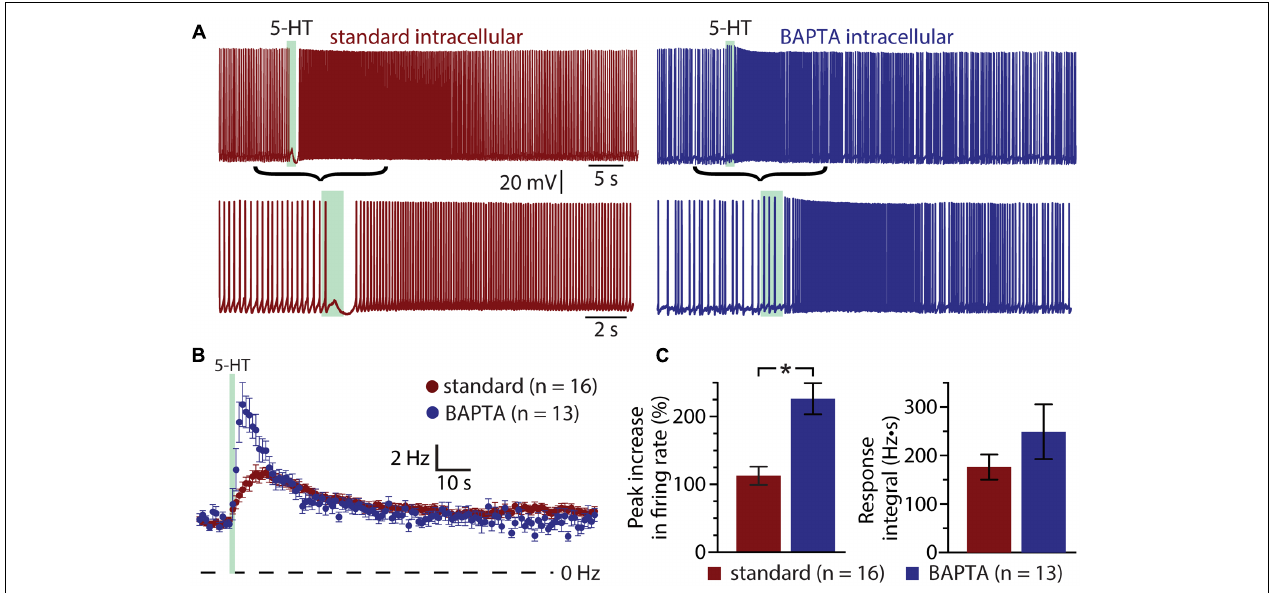
FIGURE 4 | Serotonergic excitation of COM neurons is not calcium-dependent. (A) Serotonergic responses in COM neurons recorded with standard intracellular solution (red) or with a solution containing 10 mM BAPTA (blue). Lower traces show the responses at a faster timescale. (B) Plots of mean ( ± SEM) instantaneous spike frequencies in control (red; n =16) and BAPTA-containing (blue; n =13) COM neurons. (C) Comparisons of the peak increase in instantaneous spike frequencies (left) and response integrals (right) for COM neurons recorded in control (red) or BAPTA (blue)